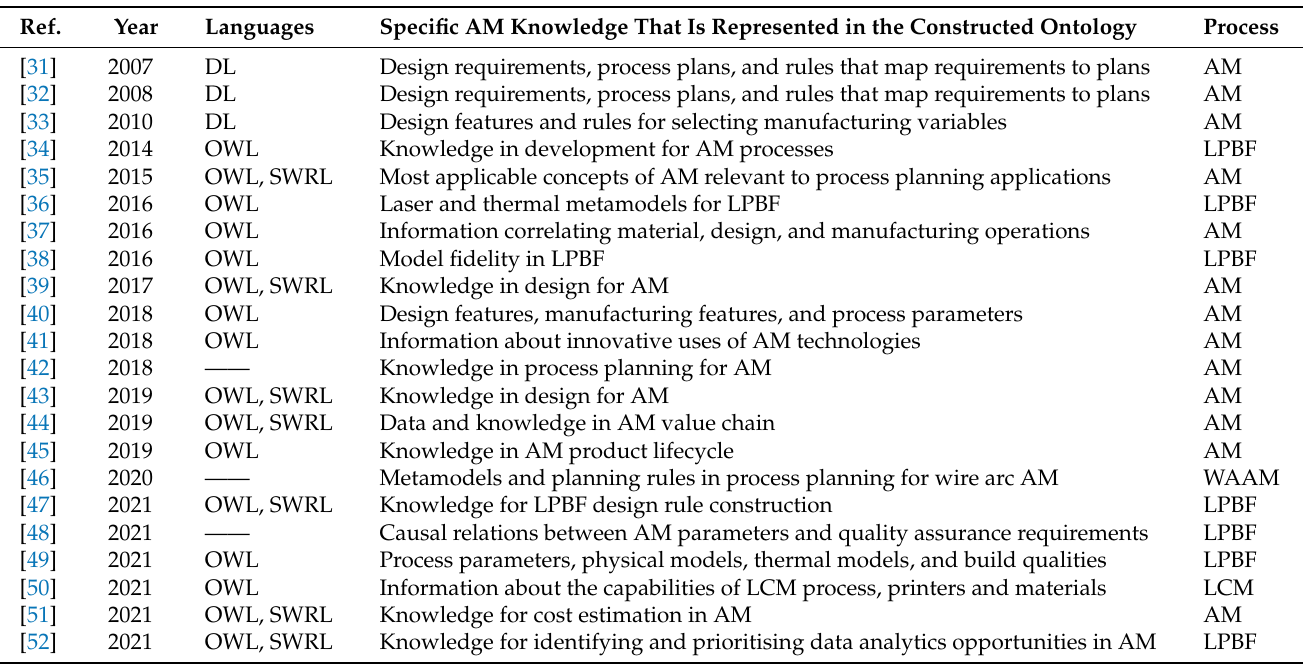
Table 2. Overview of existing ontologies for AM knowledge representation.